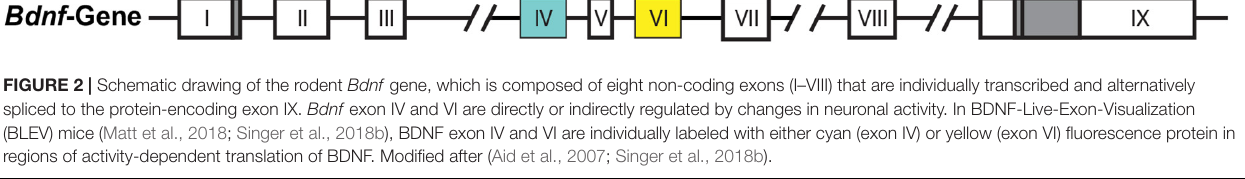
( Figure 2 ). Both exon IV ( Figure 2 , cyan) and exon VI ( Figure 2 , yellow) comprise promoters directly or